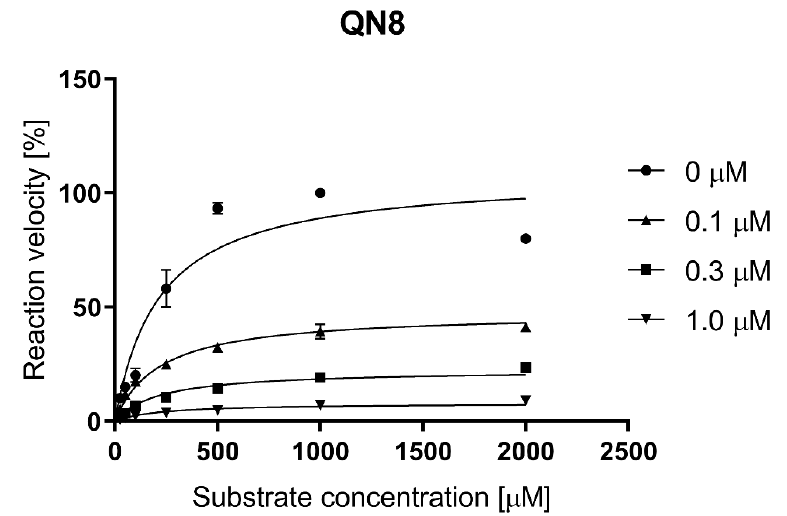
Figure 6. Inhibition kinetics of hr AChE by compound QN8 .